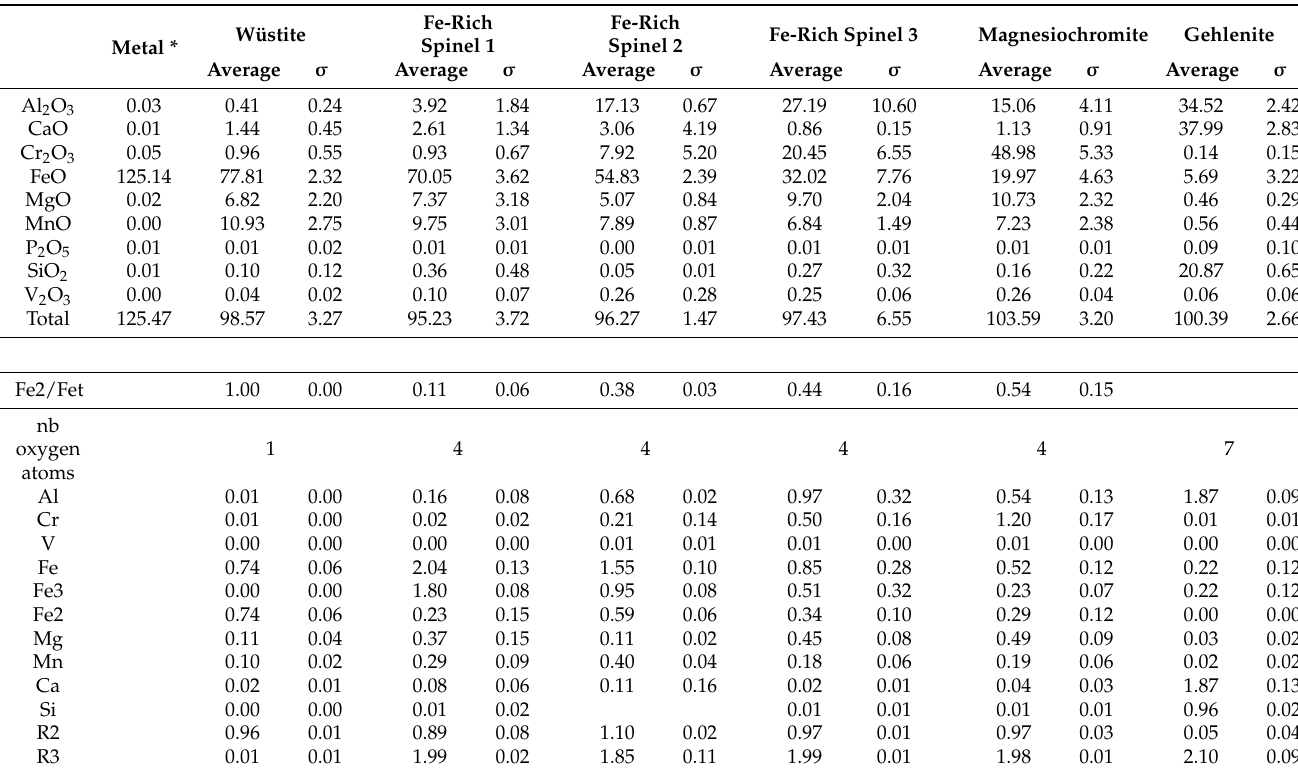
Figure 10. Mineral phases content and distribution in the size fractions +0–250 µ m, +250–500 µ m and +500–1000 µ m after attrition of the non-magnetic fraction during 40 min. Table 7. Average chemical compositions and standard deviation ( σ ) of minerals identified in the magnetic fraction. Compositions were acquired using electron microprobe and expressed in weight percent of oxides. The structural formulae were calculated on the basis of the number of oxygen atoms in the mineral (1 for wüstite, 4 for minerals of the spinel group including magnetite and chromite, and 7 for gehlenite), and expressed in atom per formula unit